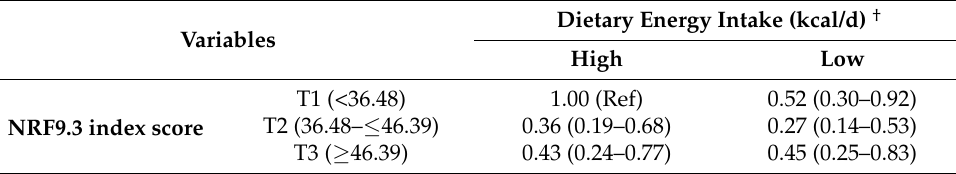
Table 3. The joint effect between dietary energy intake and NRF9.3 index score on the overall survival of ovarian cancer patients *.